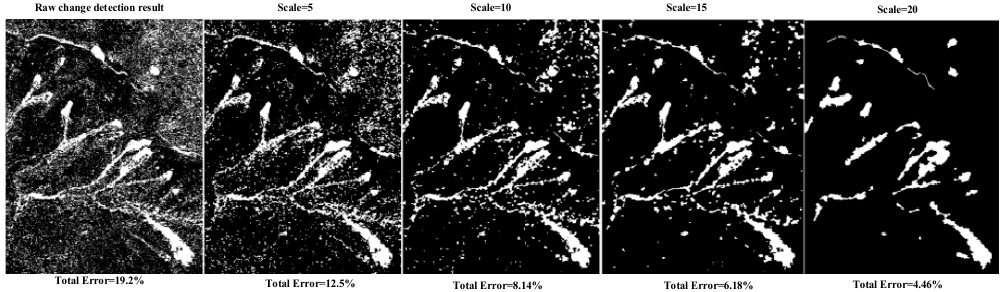
Figure 13. Different change detection results using the proposed OBEM with different scales but fixed shape and compactness at 0.8 and 0.9, respectively.